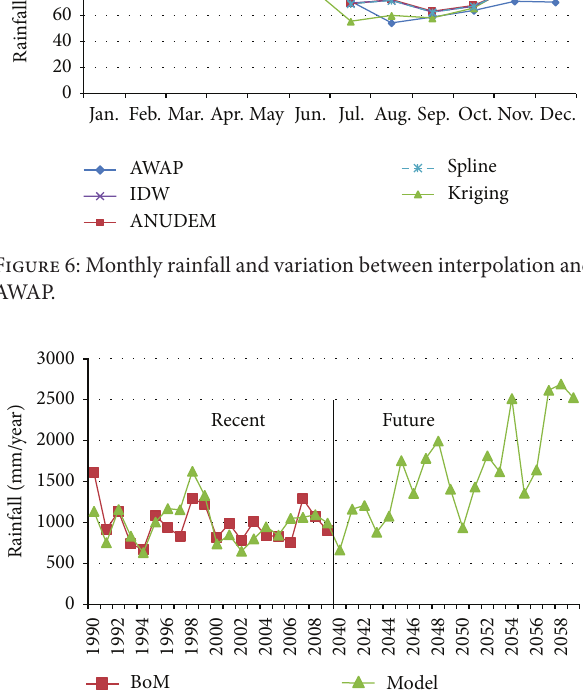
Figure 7: Predicted temporal change of rainfall in Greater Sydney